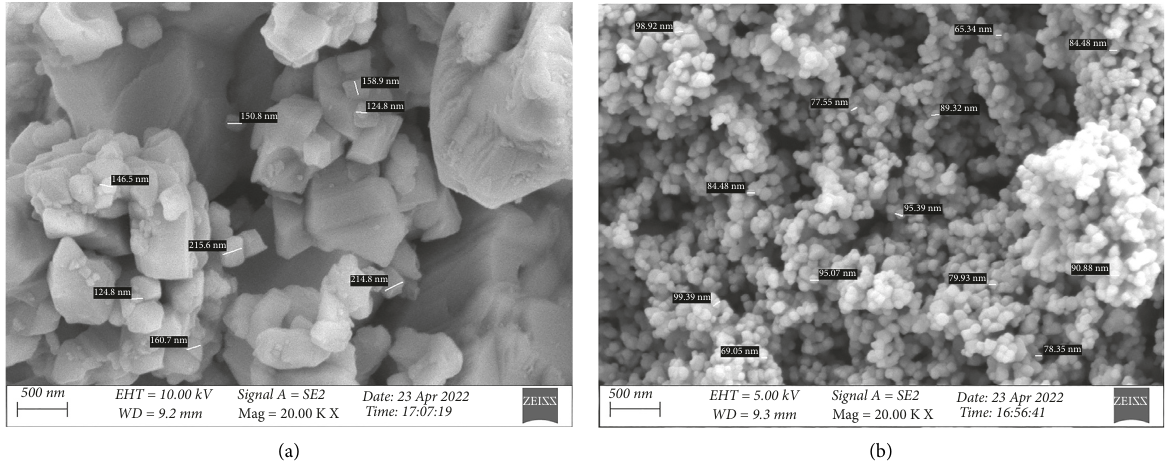
Figure 1: (a) SEM image of CuO. (b) SEM image of TiO EDS Layered Image 2